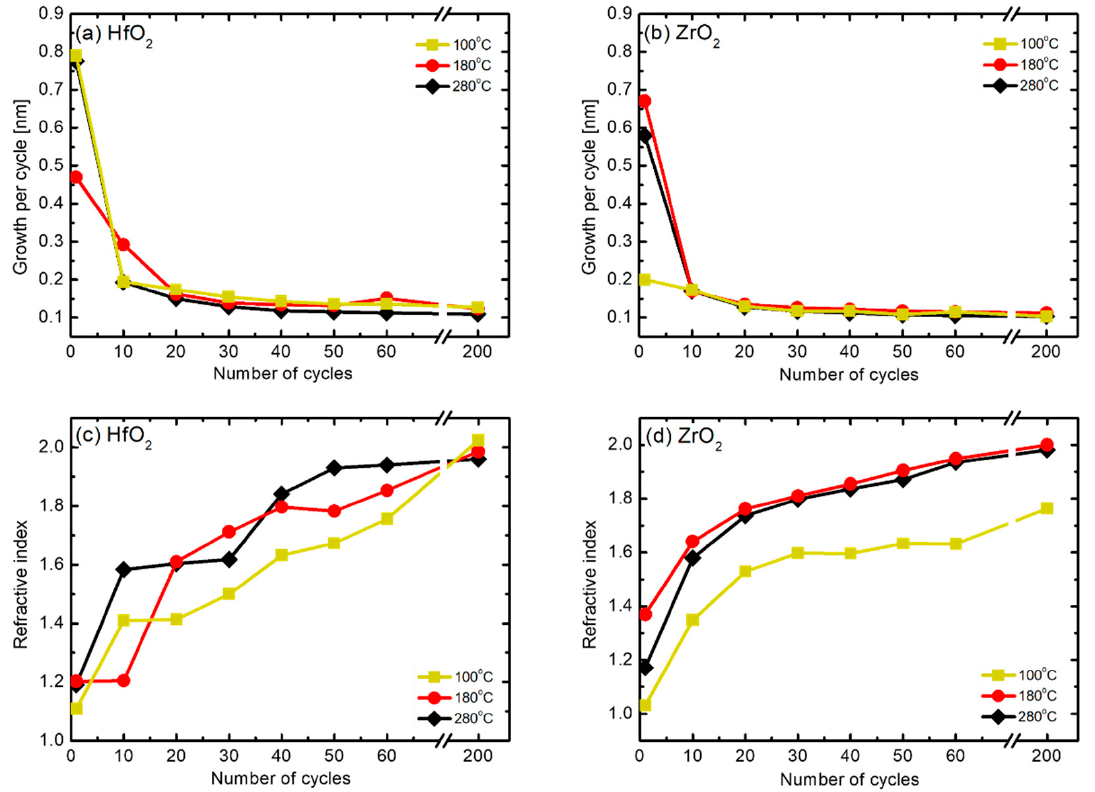
Figure 2. Changes in the ( a , b ) growth per cycle (GPC) and ( c , d ) refractive index of HfO 2 and ZrO 2 single thin films according to the number of cycles at different substrate temperatures.